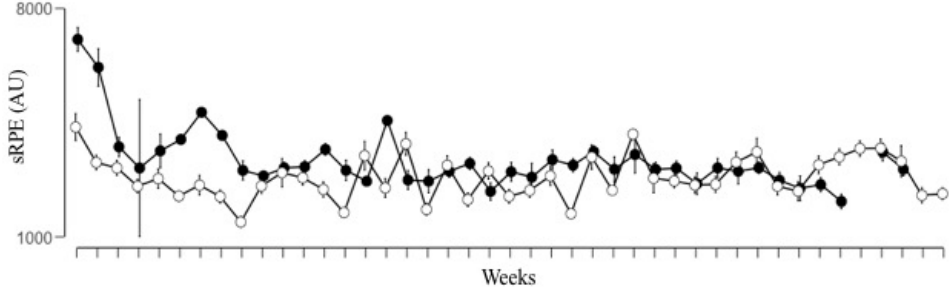
Figure 2. Distribution of the weekly accumulated internal load of subjective perception of effort (sRPE) in arbitrary units (AU) for the seasons 2017–2018 (o) and 2018–2019 ( •